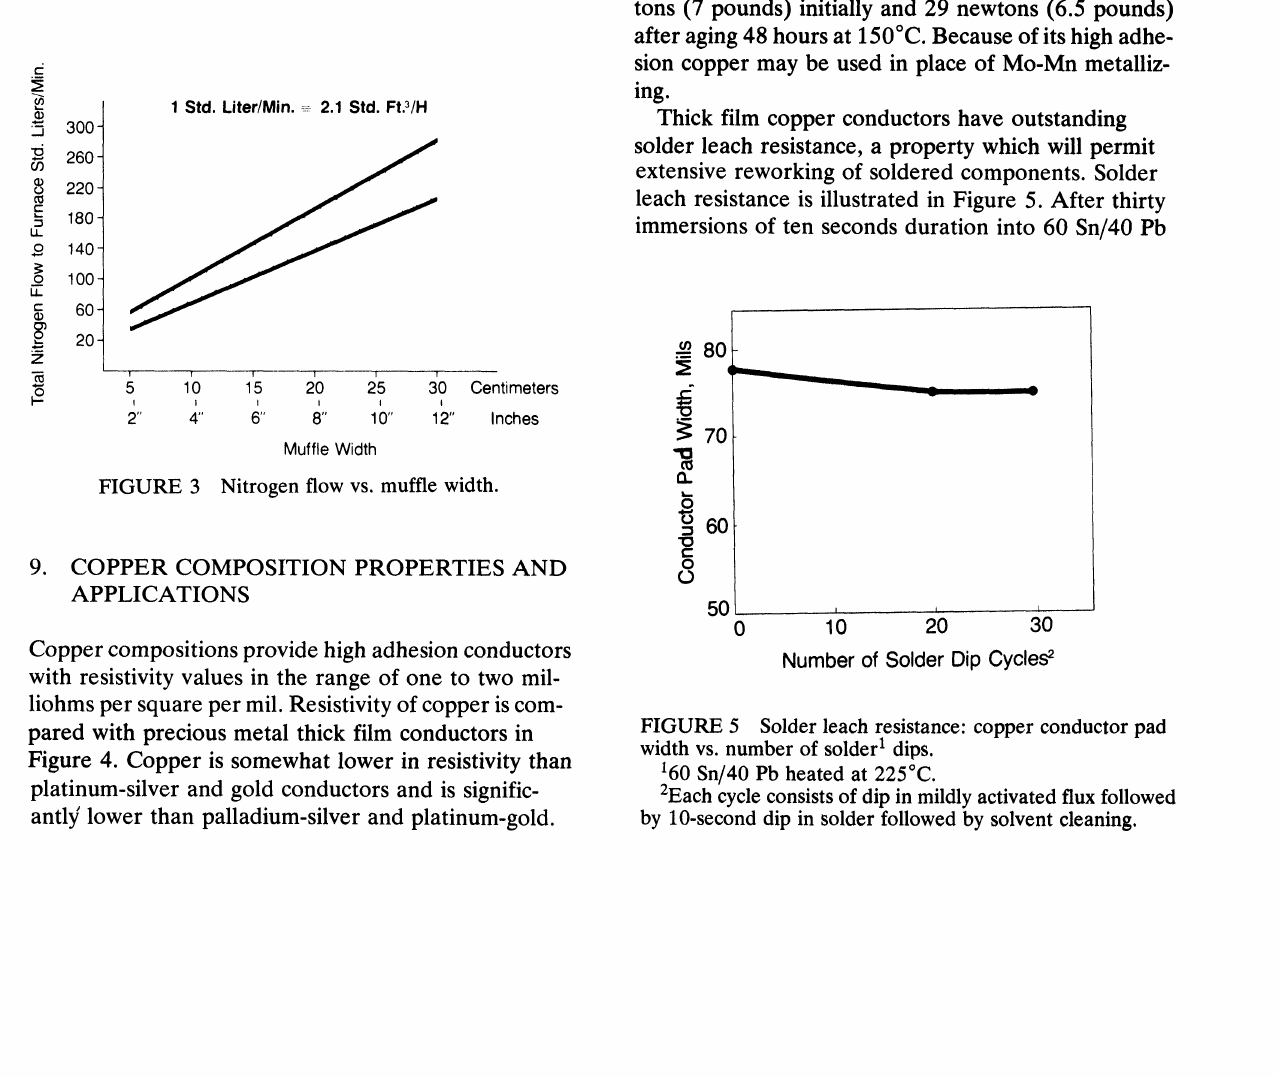
FIGURE 3 Nitrogen flow vs. muffle width.